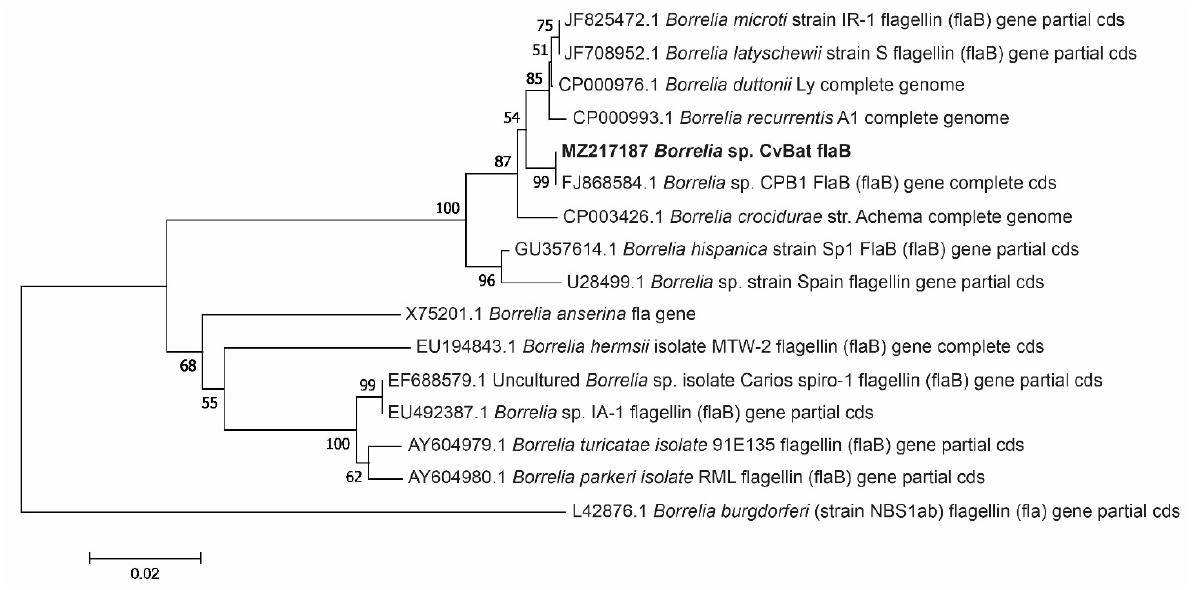
Figure 3. Phylogenetic tree based on flaB gene sequences of Borrelia species. Sequences detected in our study (“MZ217187 Borrelia sp. CvBat flaB”, n = 6) are highlighted in bold.